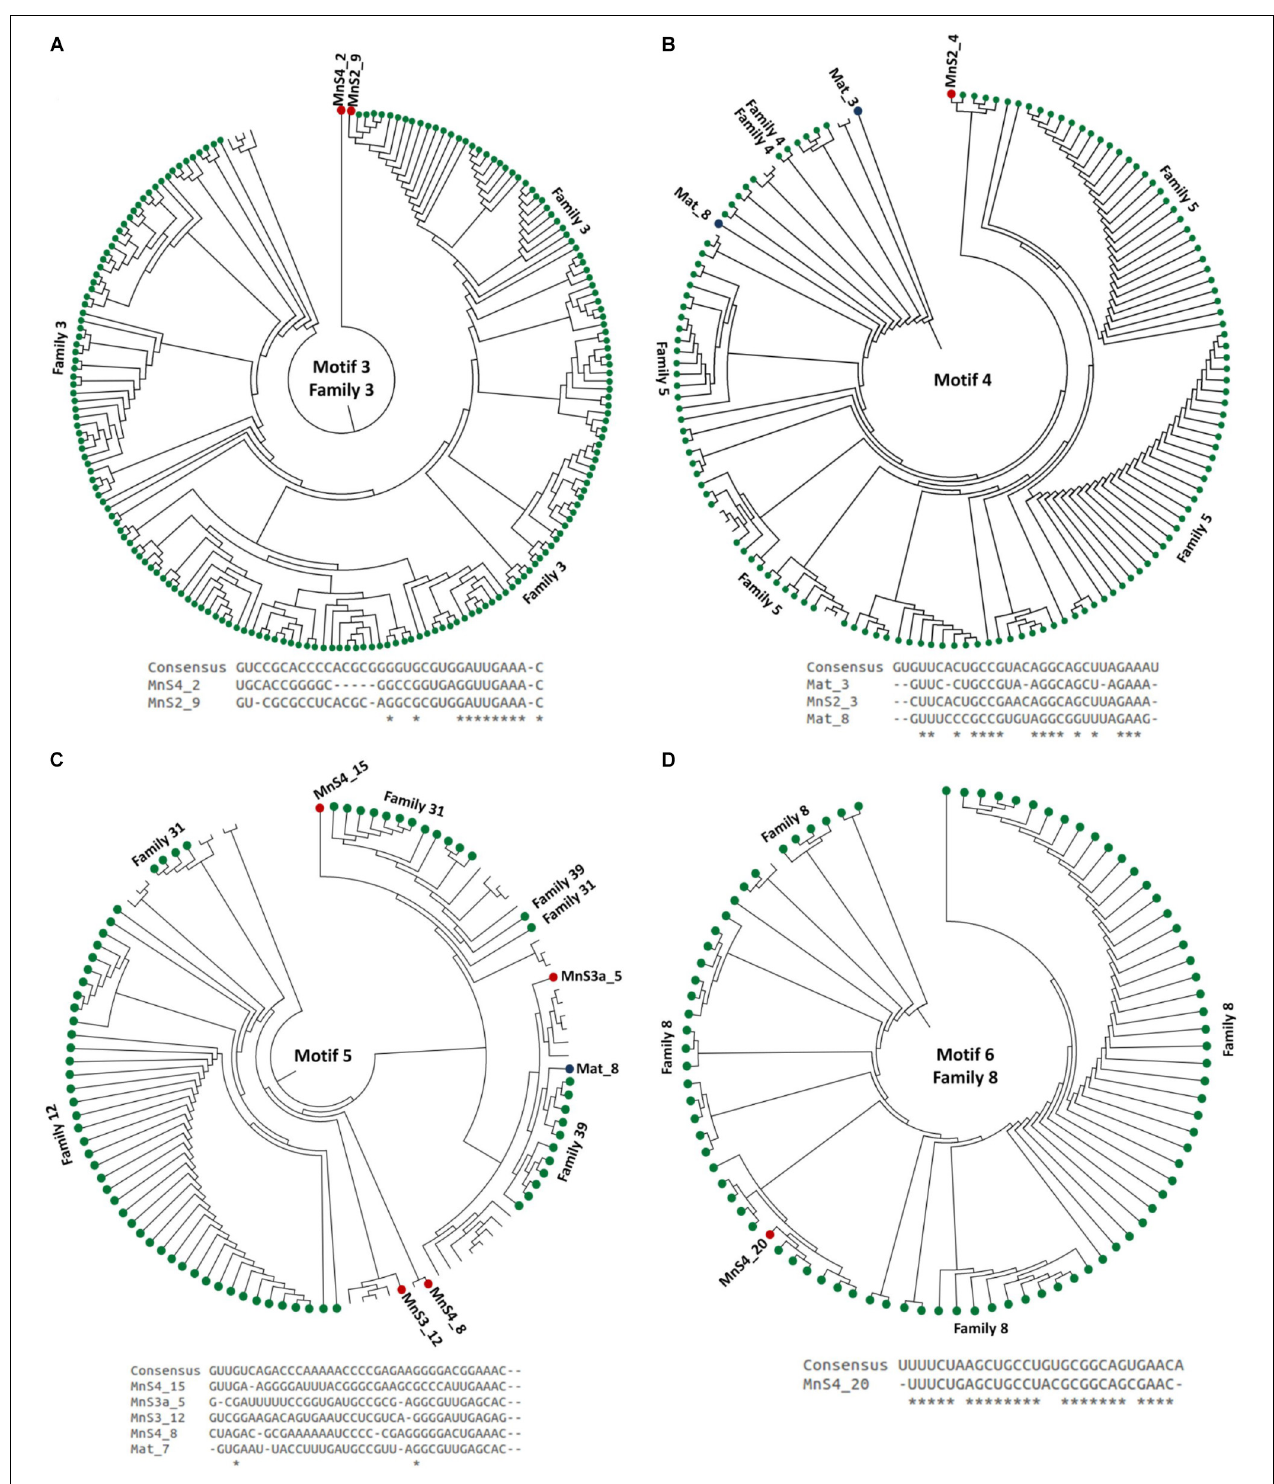
FIGURE 3 | Dendrograms showing the relationship between repeat consensus sequences of the CRISPR cassettes belonging to (A) motif 1, (B) Motif 2, (C) Motif 3, and (D) Motif 4, identified across microbial mat and sediment metagenomes. The red and blue nodes represent the repeat sequences belonging to the sediment and microbial mats. Green nodes represent the sequences in the CRISPR database with the family level assignments. All the sequences here were used from the CRISPR database with known motif level assignments. Below each dendrogram, there is an alignment between the consensus repeat sequences generated for a specific CRISPRs motif and the repeat sequences identified in microbial mat and sediment